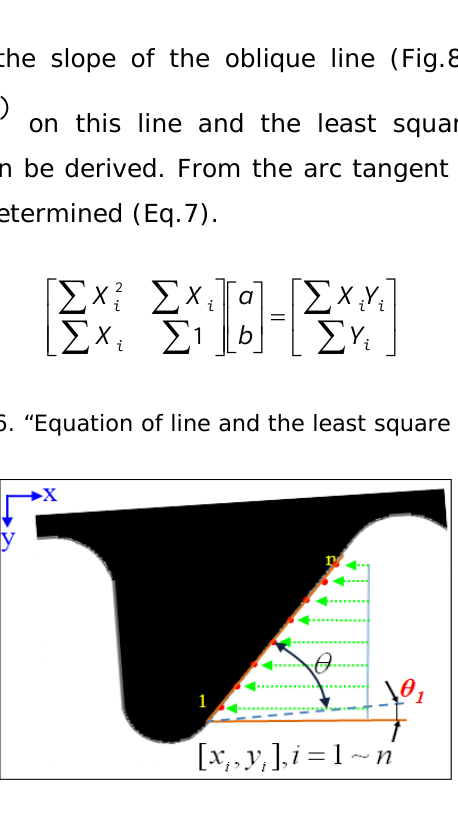
Figure 8. “Pressure angle